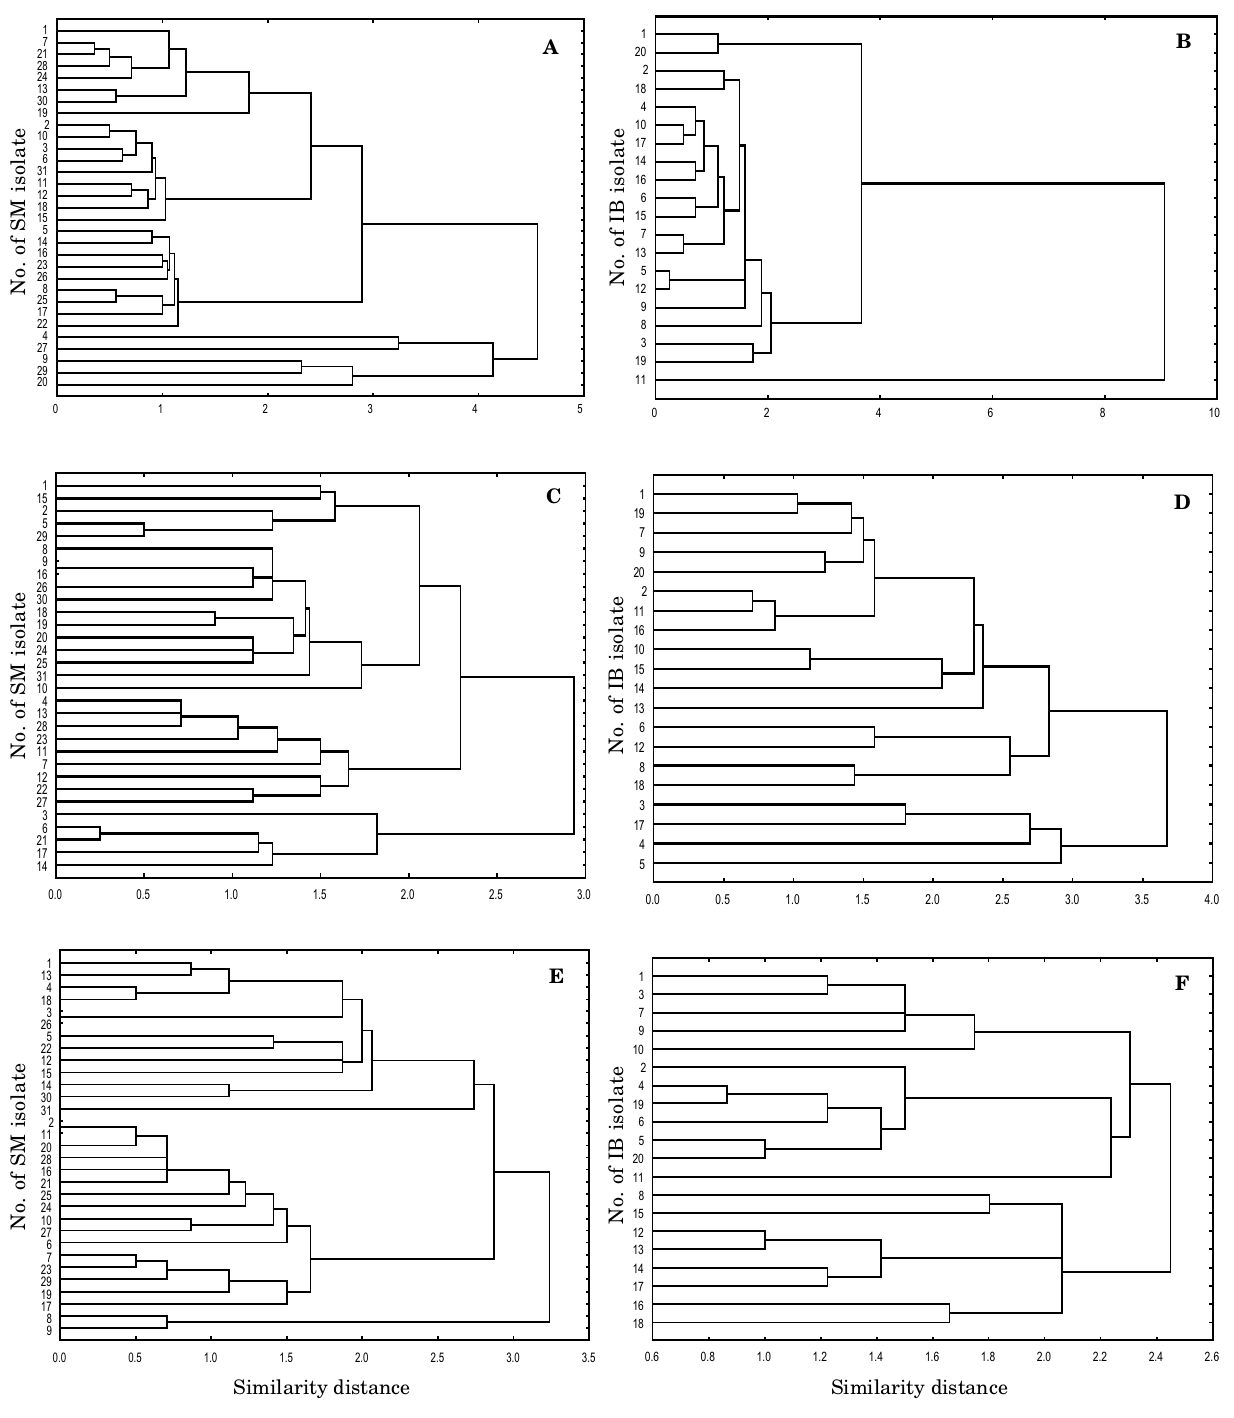
Fig. 2. Phenograms based on average linkage cluster analysis of 31 bacterial isolates from eggplant (SM) and 20 bacterial isolates from sweet potato (IB) against Macrophomina phaseolina (A, B); Helminthosporium tetramera (C, D); Alternaria tenuis (E, F) (this page); Fusarium solani (G, H); Sclerotium rolfsii (I, J) (next